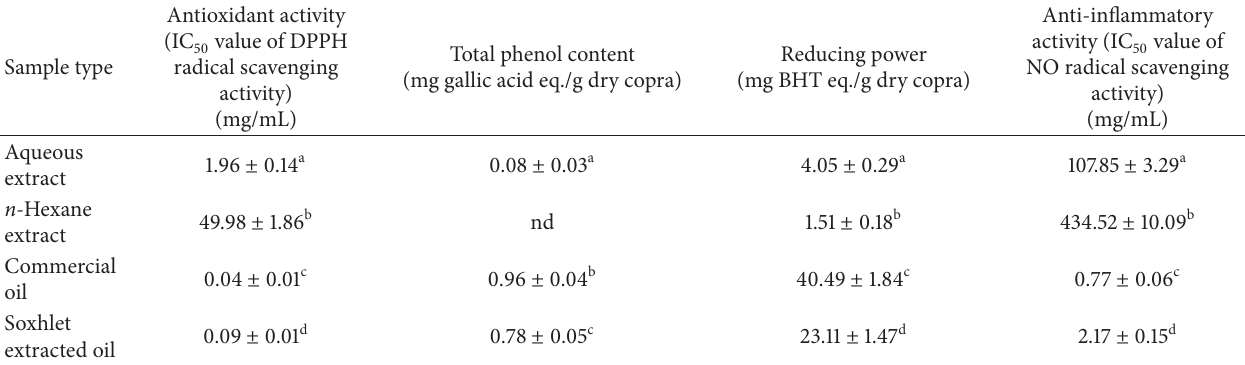
Table 6: Quantitative phytochemical analyses of aqueous and solvent coconut copra extracts and oils e .